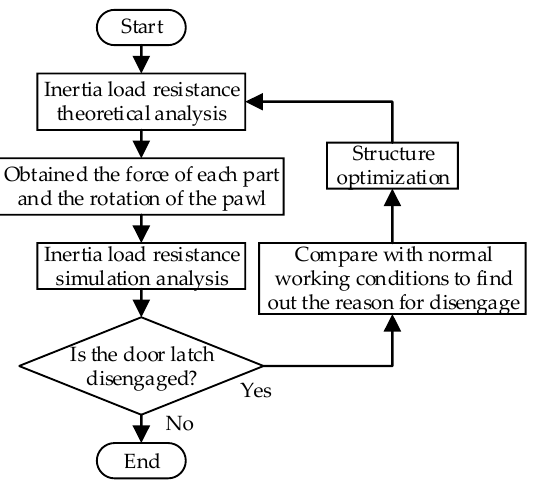
Figure 6. The flow chart of the inertia load resistance analysis of the latch of the light truck door